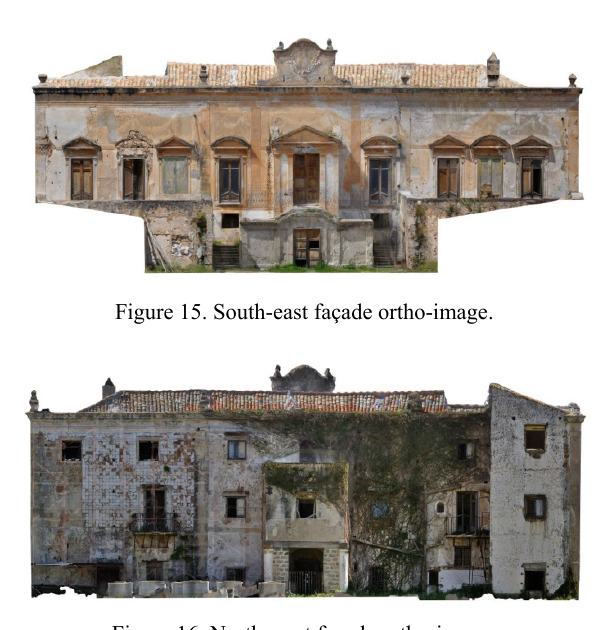
Figure 16. North-west façade ortho-image.